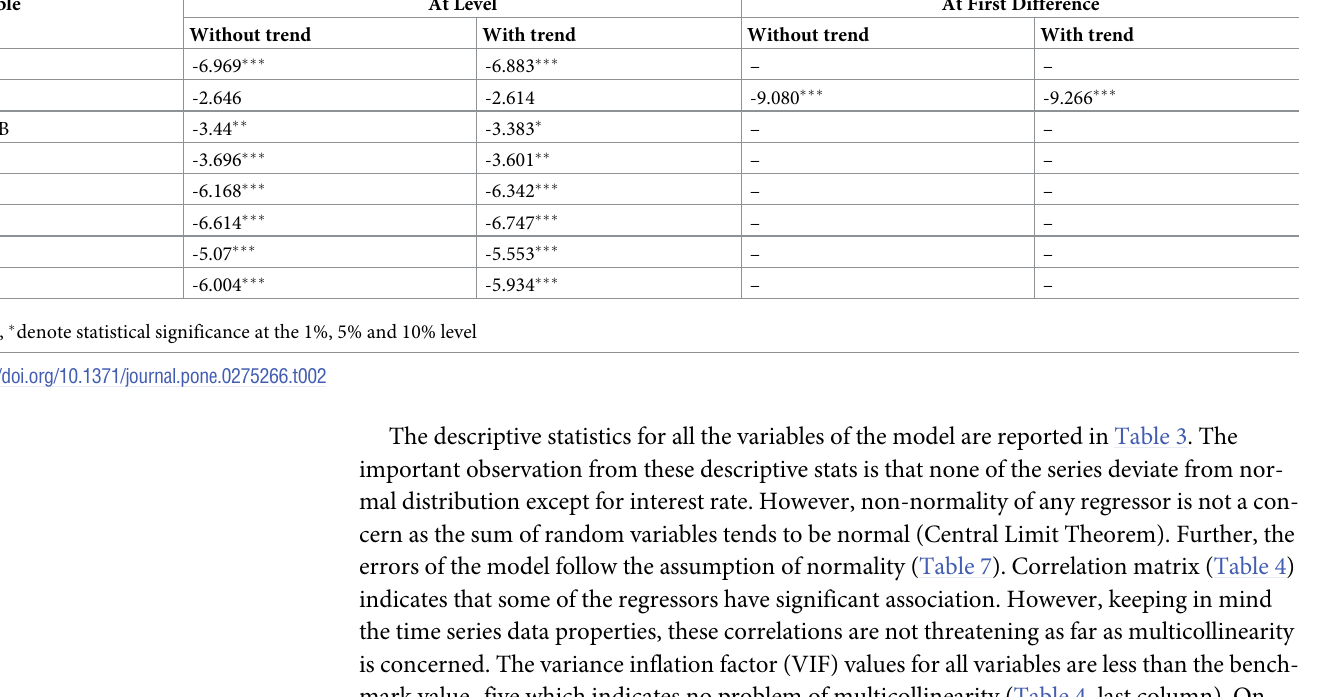
Table 2. ADF unit root test.